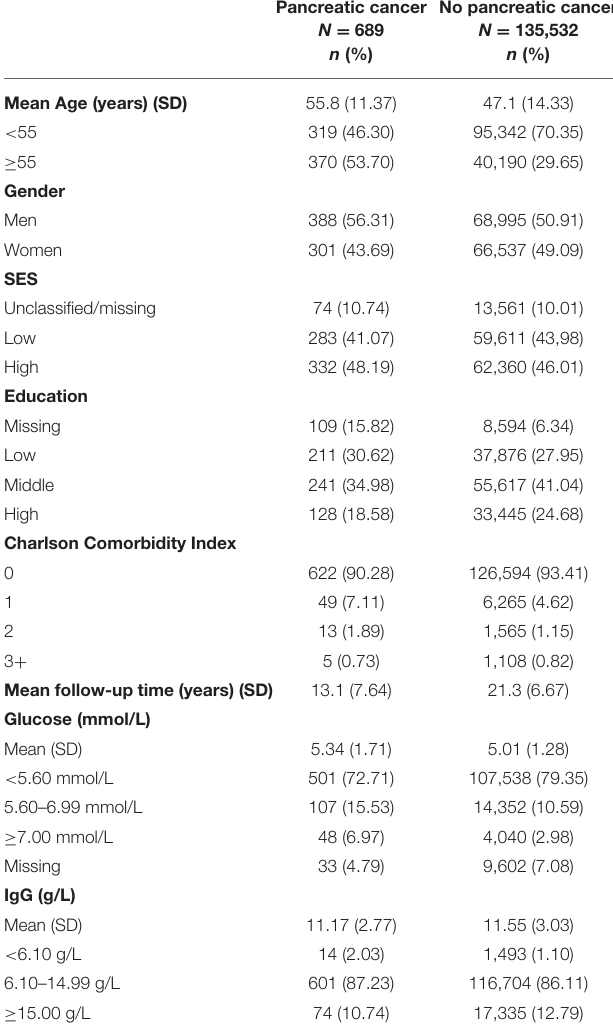
TABLE 1 | Descriptive statistics of study population with a measurement of IgG.